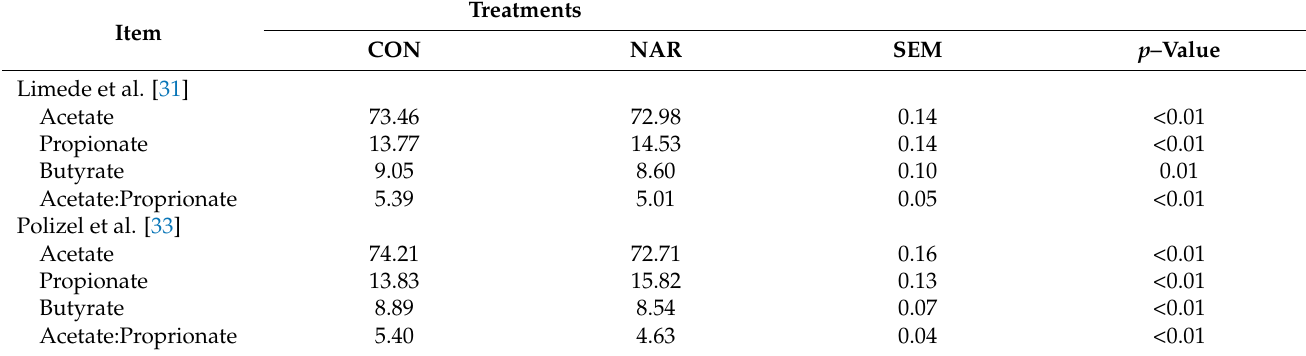
Table 3. Rumen short-chain fatty acids (SCFA) concentrations (mM/100 mM) in steers receiving forage-based diets supplemented or not (CON, n = 8) with narasin (NAR, n = 8). CON = no feed additives; NAR = inclusion of 13 ppm of